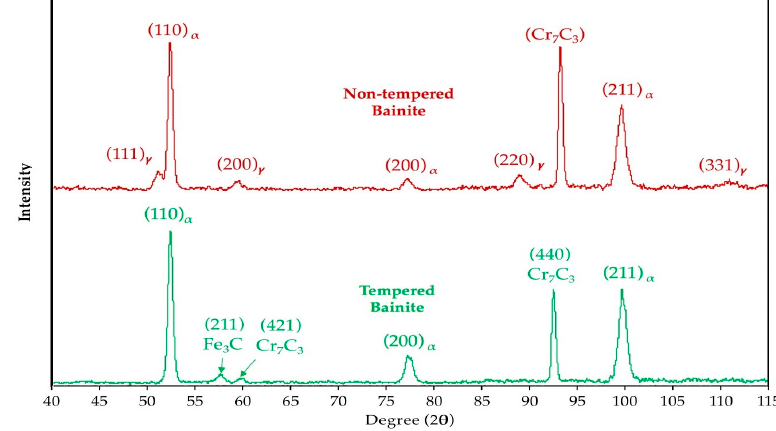
Figure 7. XRD spectra of bainite and non-isothermal tempered bainite at heating rate of 5 °C/min.